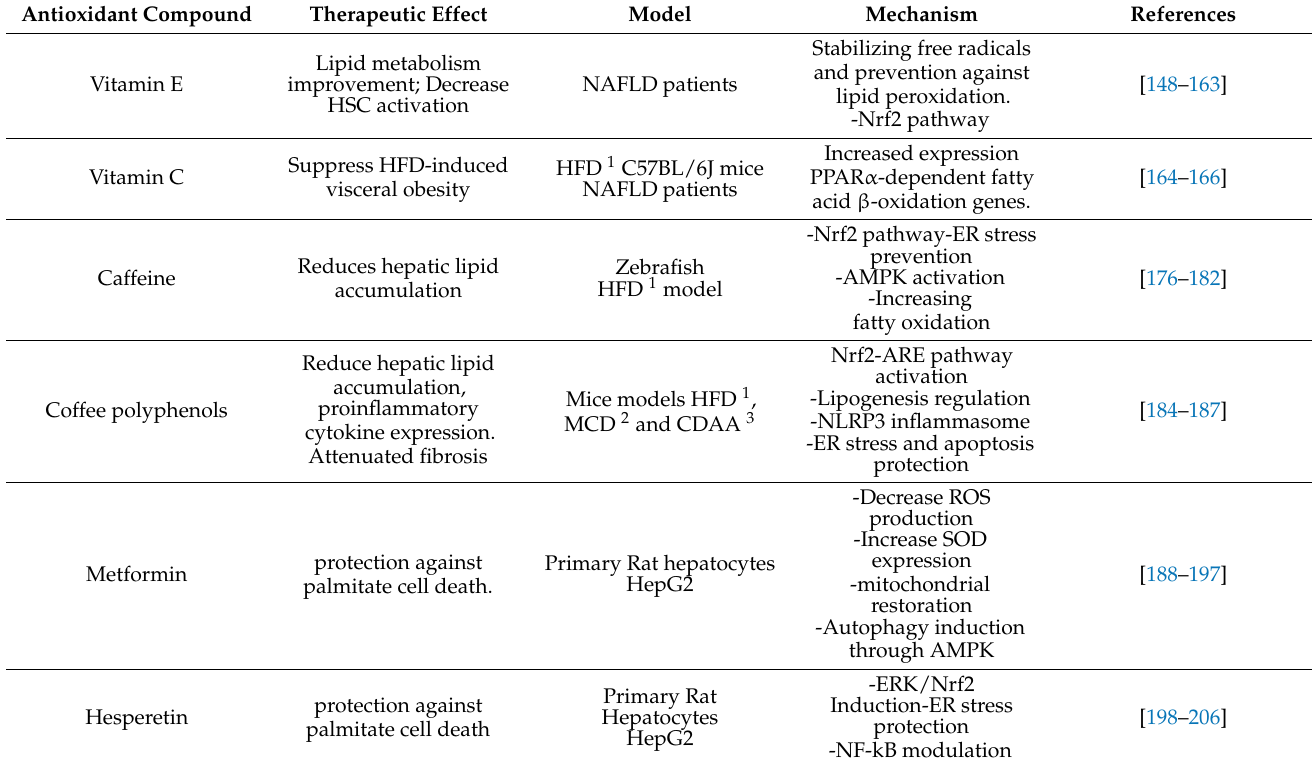
Table 1. Potential therapeutic compounds based on antioxidant